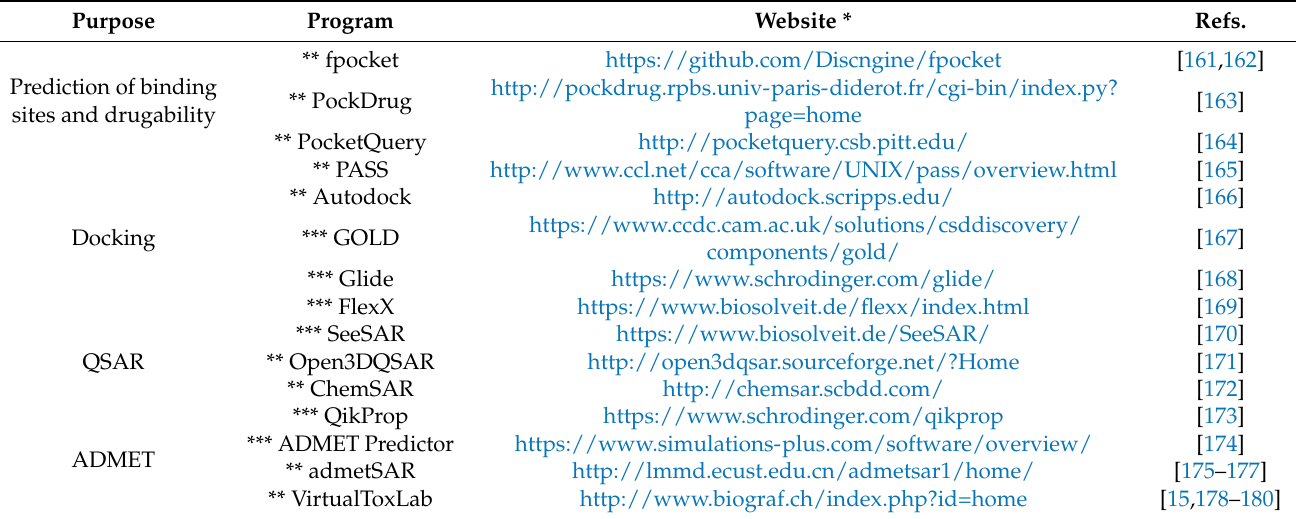
Table 7. Accessible websites to retrieve software for